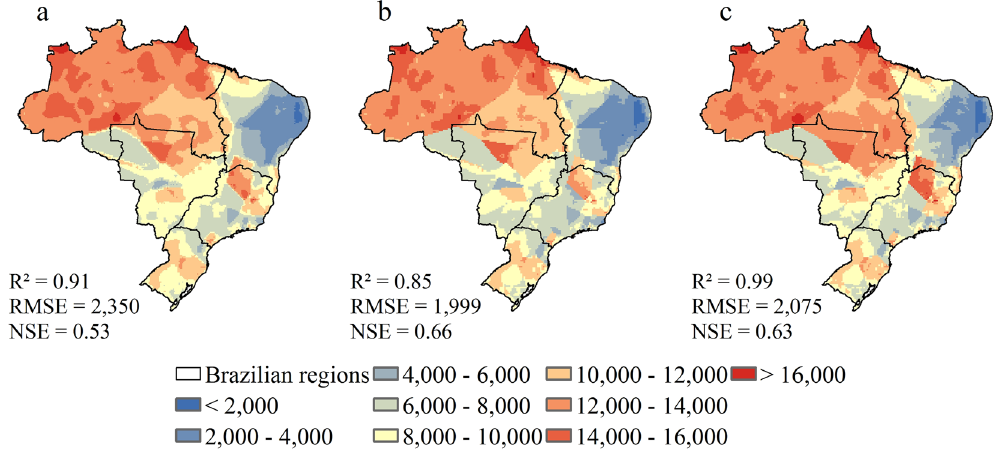
Figure 1. Rainfall erosivity for Brazilian regions. ( a ) Observed rainfall erosivity (1980–2013); ( b ) HadGEM2-ES estimations for baseline (1961–2005); ( c ) MIROC5 estimations for baseline (1961–2005). Values are in MJ mm ha − 1 h − 1 year − 1 . Maps created with ESRI ArcGIS 10.1